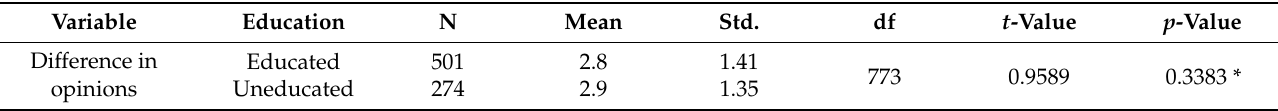
Table 7. Difference in external factors influence for purchasing luxury brands (by education).